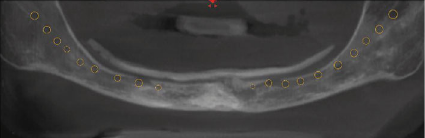
Figure 2: Panoramic view of the CBCT scan. The mandibular canal is traced. The opening of a neurovascular bundle under soft tissue is noted.